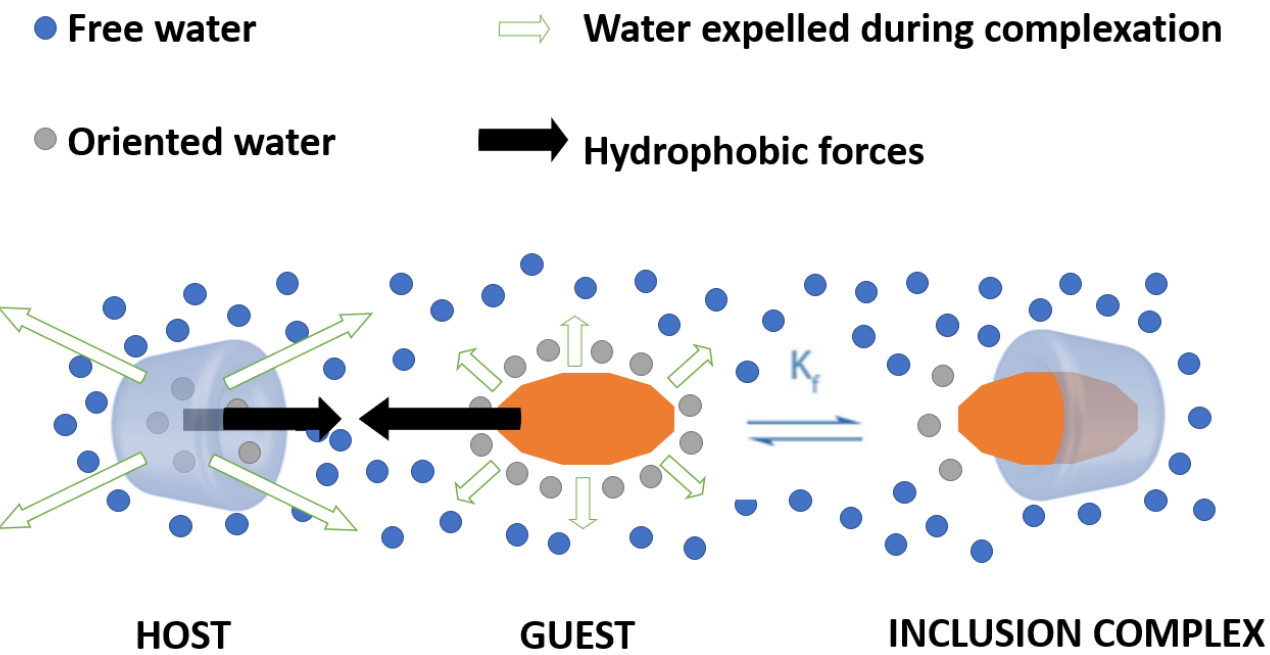
Figure 2. Schematic representation of the formation of an inclusion complex between a CD (host) and a guest.